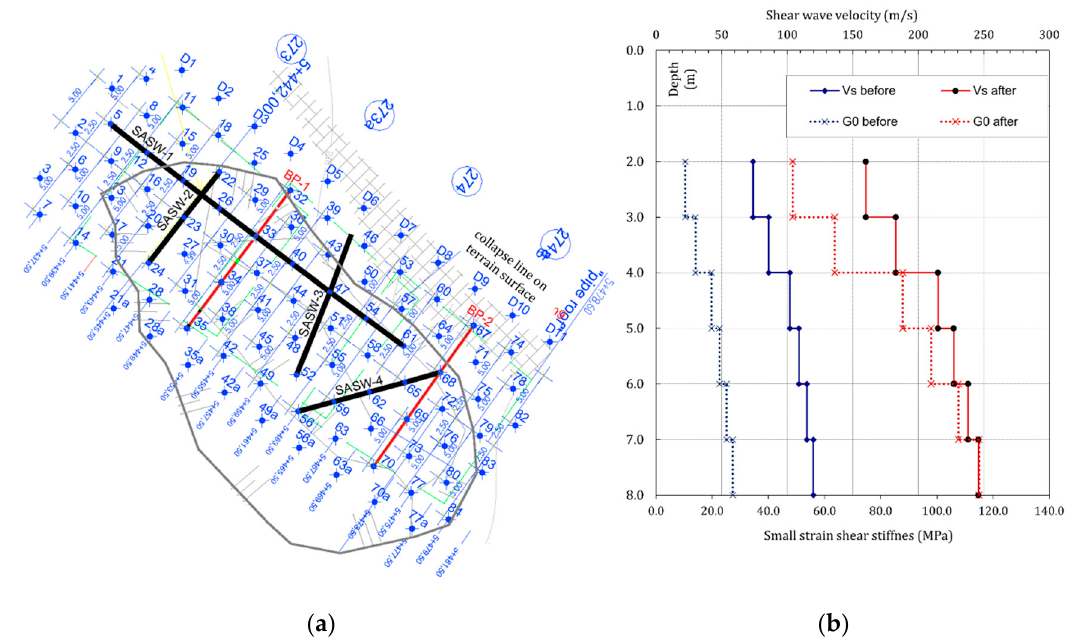
Figure 10. St. Kuzam tunnel collapse: ( a ) layout of soil improvement with positions of spectral analysis of surface waves (SASW) profiles, ( b ) S-wave velocities and small strain stiffness before and after the improvement.